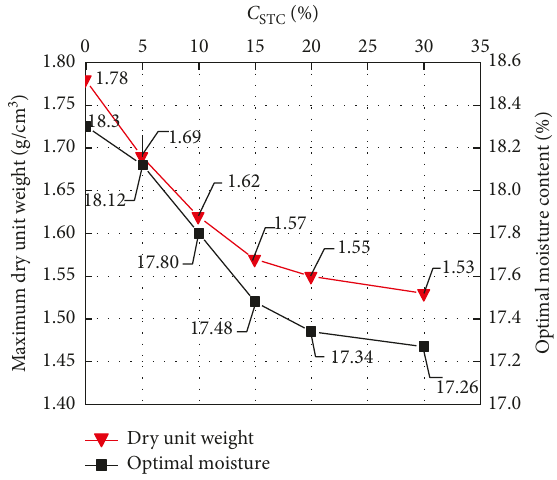
Figure 3: Variations of dry unit weight and the corresponding optimal moisture content for mixtures.